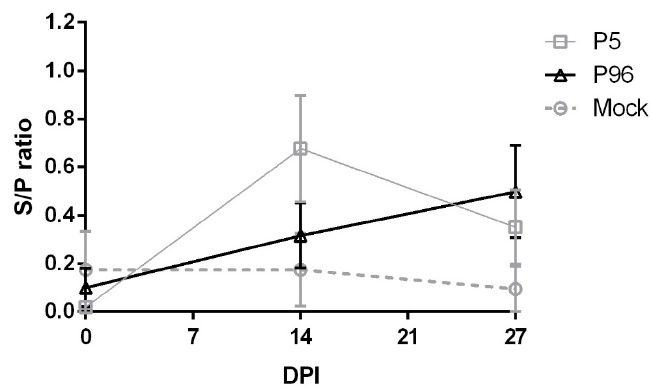
Figure 5. Changes in PEDV-specific mucosal IgA levels obtained from fecal swabs after PEDV strain Pintung 52 (PEDVPT)-P5 or PEDVPT-P96 inoculation of pigs. Each fecal swab was diluted with 700 µ L PBS and filtered; the supernatants were diluted two-fold, and the levels of PEDV-specific IgA were detected by ELISA with PEDV virions as the coating antigen. The results obtained were expressed as sample-to-positive ratios (S/P ratio), which were defined as the difference between the OD values of sample and negative control divided by the difference between the OD values of positive and negative control, with SEM. The black, gray, and dashed lines illustrate the results of the PEDVPT-P96-inoculated group, PEDVPT-P5-inoculated group, and mock-infected group, respectively.